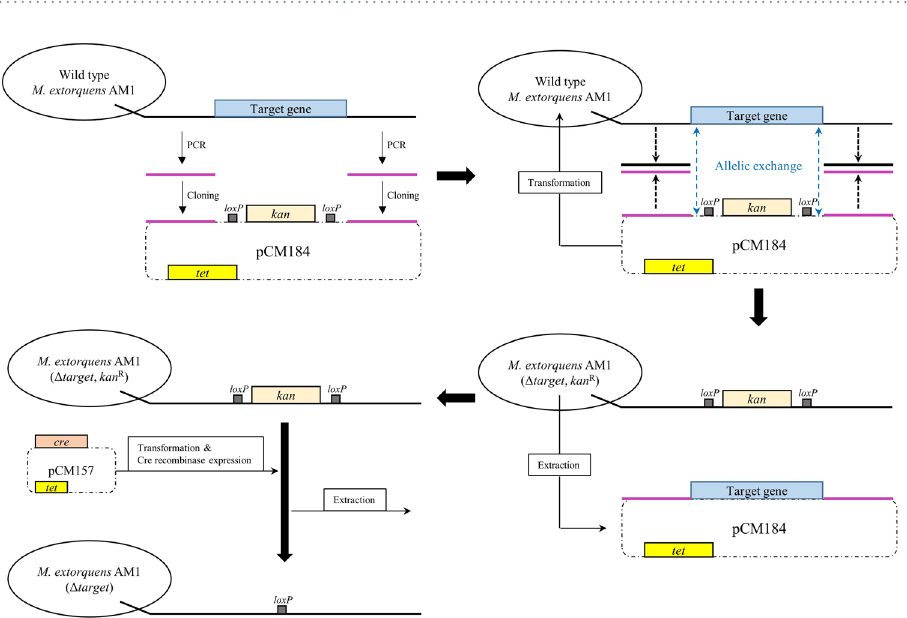
Figure 1. Diagram of the gene-knockout system for the construction of M. extorquens AM1 mutants. Sequences located on both sides of the target gene in the genome of M. extorquens AM1 were amplified by PCR and cloned into pCM184. The target gene was exchanged with the loxP-kan-loxP gene through homologous allelic recombination between M. extorquens AM1 and pCM184. For extraction of pCM184, M. extorquens AM1 mutants ( Δ target, KanR) were cultivated in media without kanamycin. Next, cre recombinase was expressed on pCM157 to eliminate the kanamycin resistance gene between loxP genes through site-specific